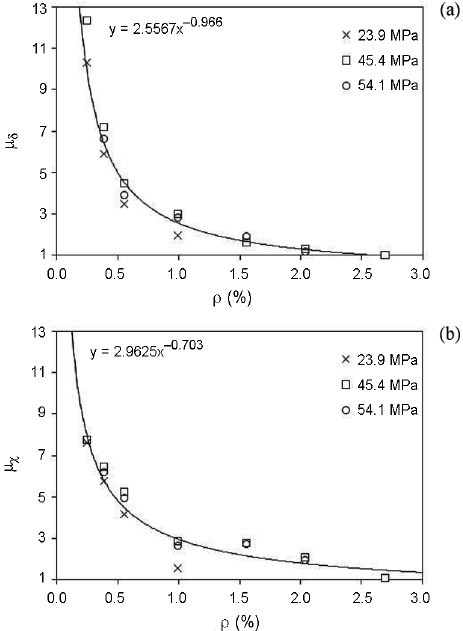
Fig. 7. Influence of concrete strength on ductility: a) index μ δ ; b) index μ χ